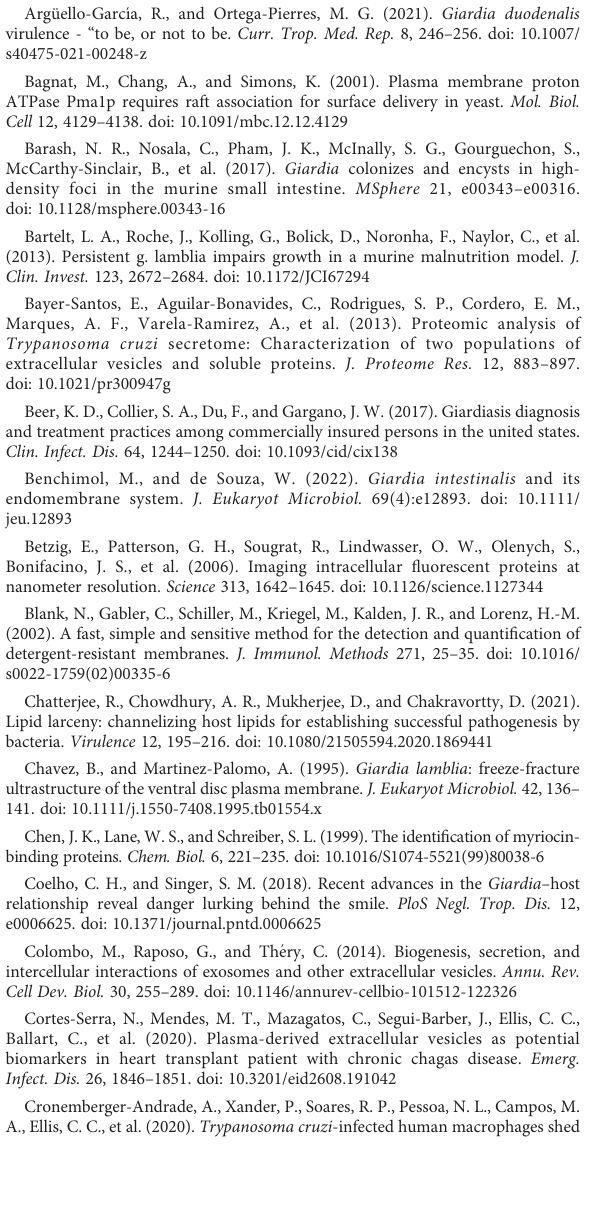
the protein names, accession numbers and the averaged normalized weighted spectral counts of the proteins. Concurrent spreadsheets show the distribution of these proteins between the three groups mentioned before as well as the gene name, organismal database and length. SUPPLEMENTARY TABLE 7 The data output was used to generate the heatmap and